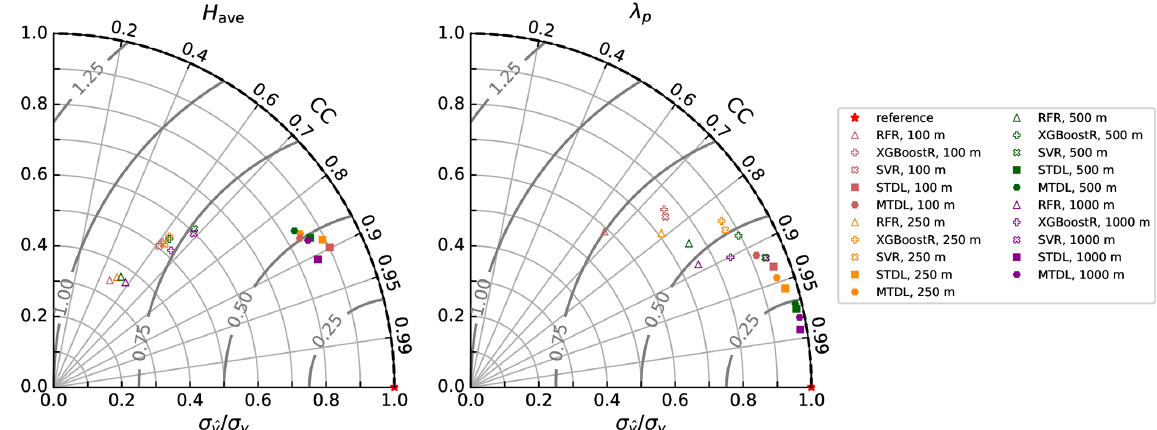
Figure 11. Taylor plots of comparing model performance across different scales where contours represent different levels of RMSE (cid:48) n